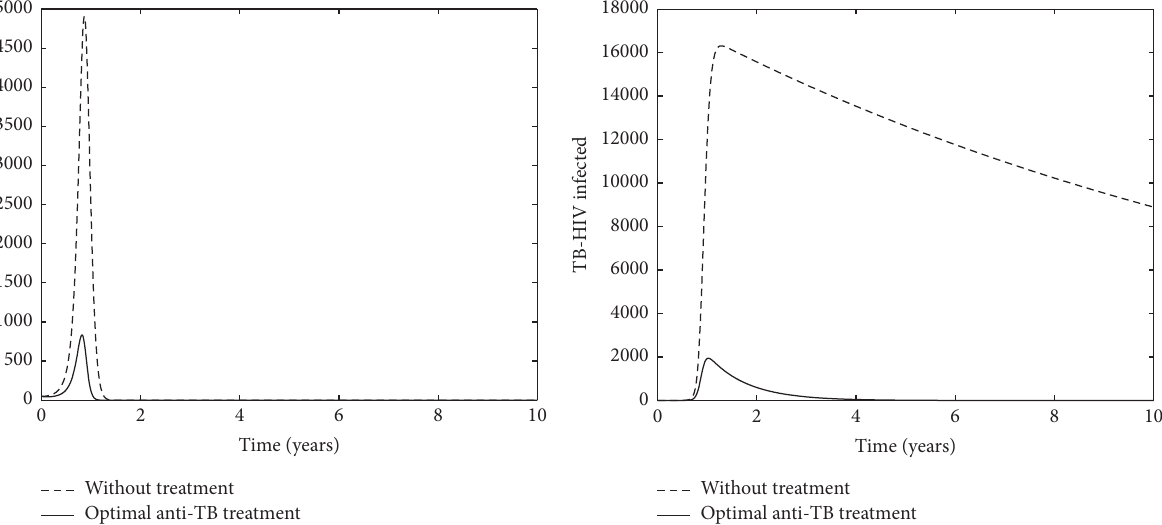
Figure 7: The dynamics of 𝐼 𝑡 and 𝐼 ℎ𝑡 using control 𝑢 ∗ 1 .